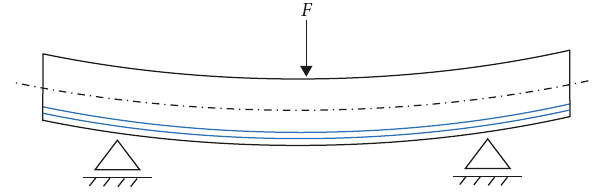
Figure 6: Tensile and bending test of the fiber overlay.